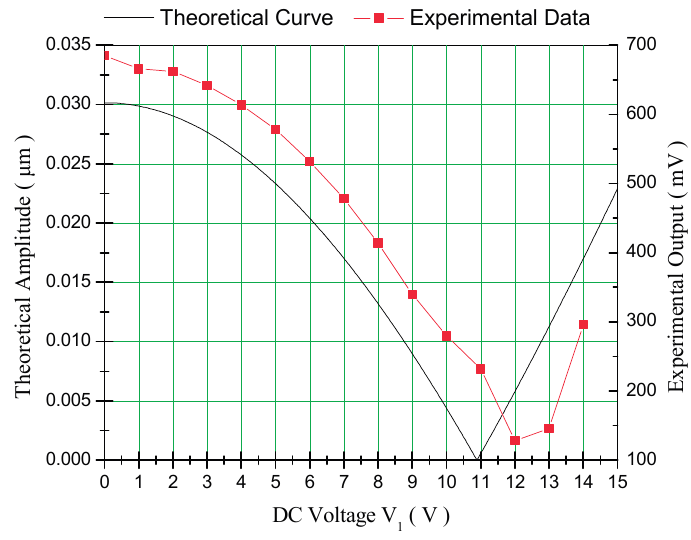
Figure 8. Relationships between the quadrature signal and the compensation voltage when the method of single group loading was employed.